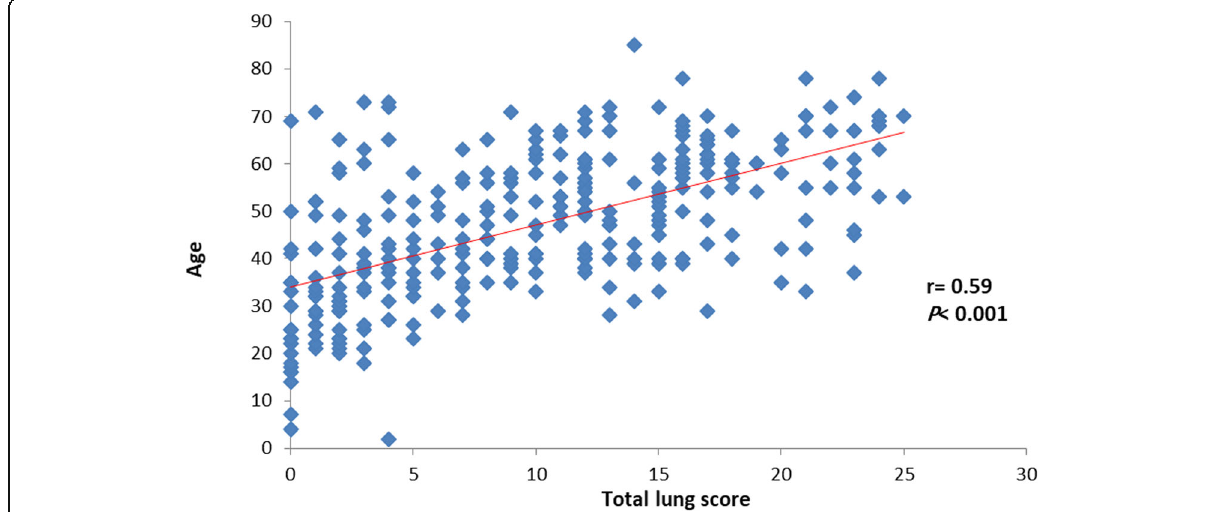
Fig. 2 Correlation between total lung score and age in male patients